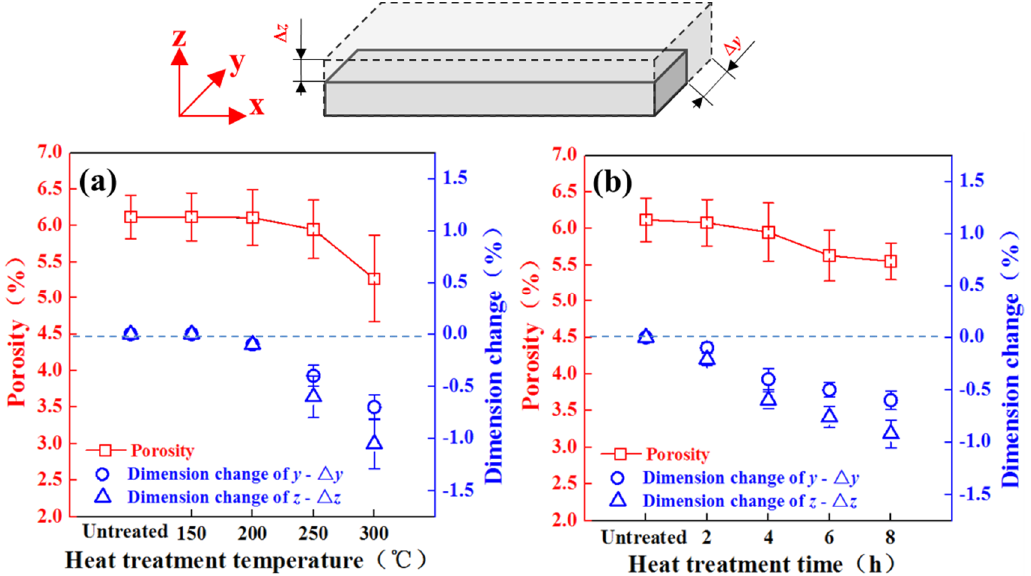
Figure 8. Effect of heat treatment process on porosity and dimensional change of FDM 3D-printed 5 wt.% CF/PEEK: ( a ) heat treatment temperature; ( b ) heat treatment time.